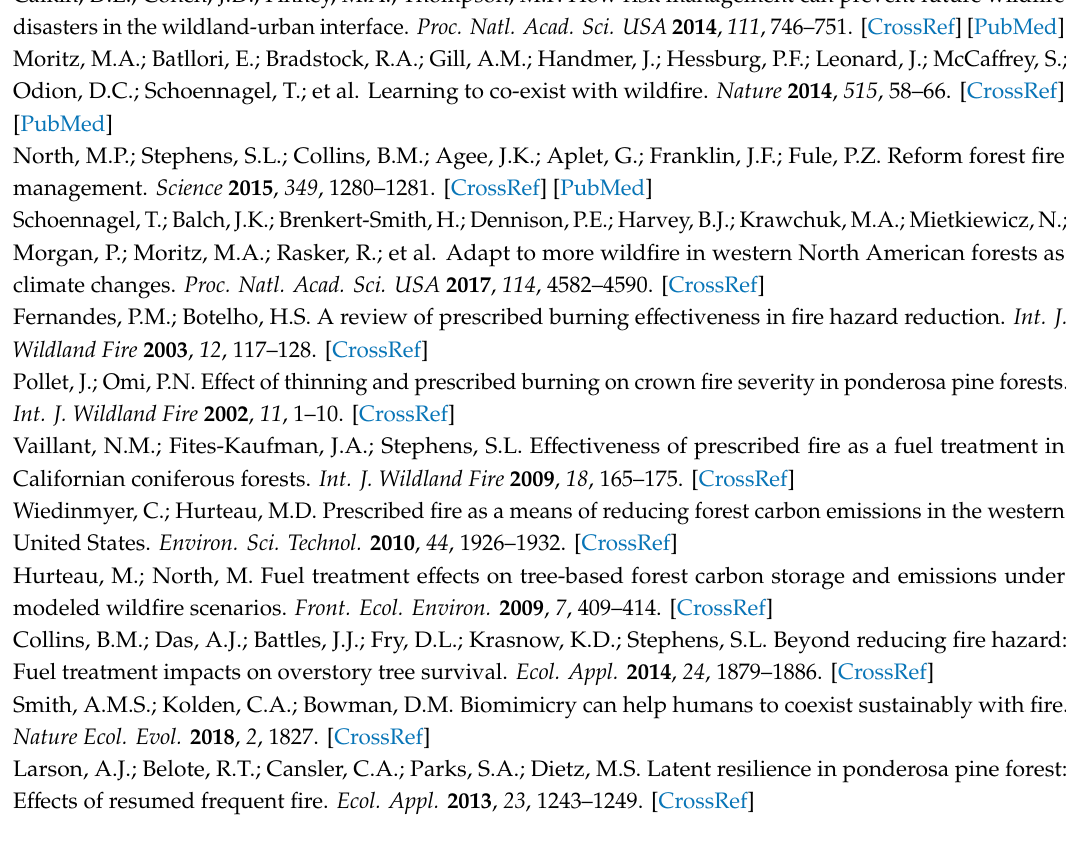
Table S1: Hectares under each primary land management agency by Geographic Area Coordination Center (GACC)